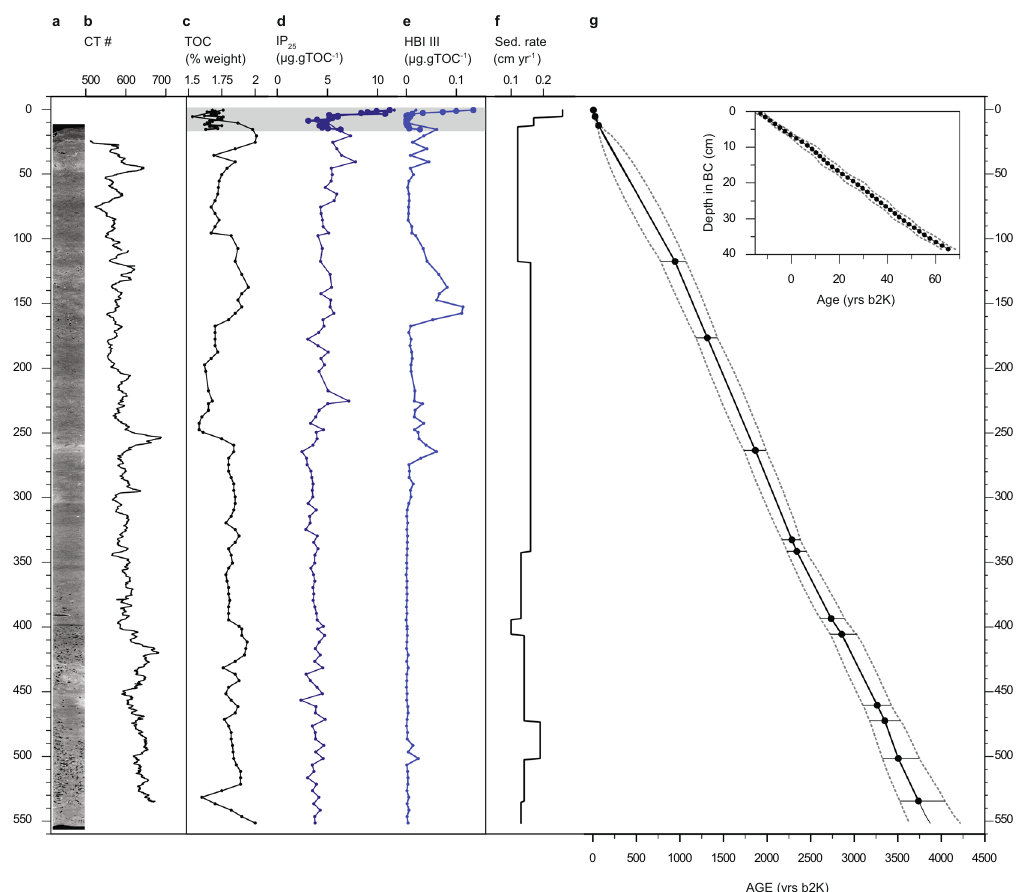
Fig. 2 Marine sediment core. a Computerised tomography scan image of the Casq1 core. b CT number. Denser areas appear whiter in the CT scan image. c Total organic carbon (TOC) percentage weight. d TOC-normalised concentrations of the sea ice biomarker IP 25. e TOC-normalised concentrations of HBI III (Triene). f Sedimentation rates. g Modelled median age-depth relationships constructed in BACON for CASQ1 and CASQ1 BC (insert). Error bars and dashed lines represent 95% con fi dence intervals (for dates see Supplementary Table 1). The grey bar indicates the stratigraphic interval covered only by the box-core